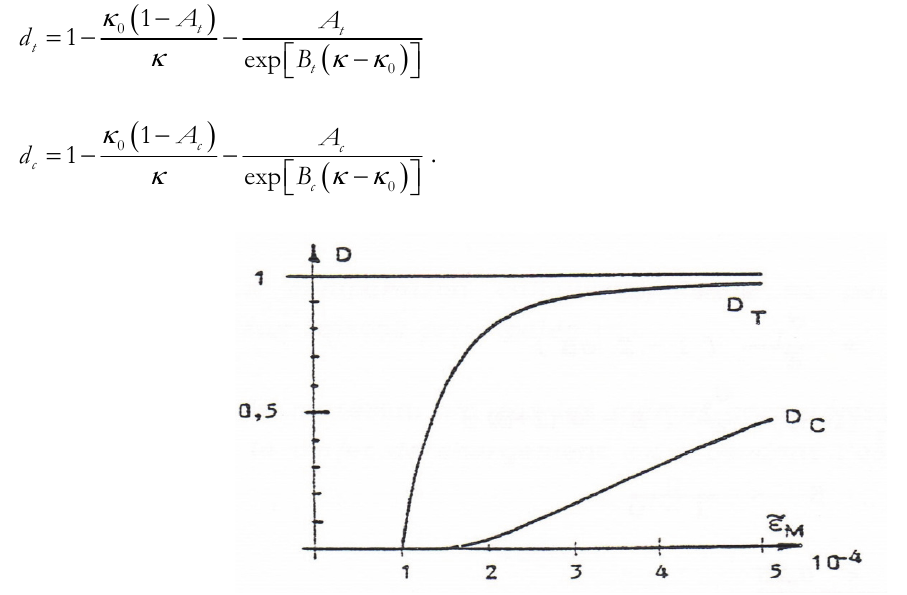
Figure 1. Evolution of two parts of damage